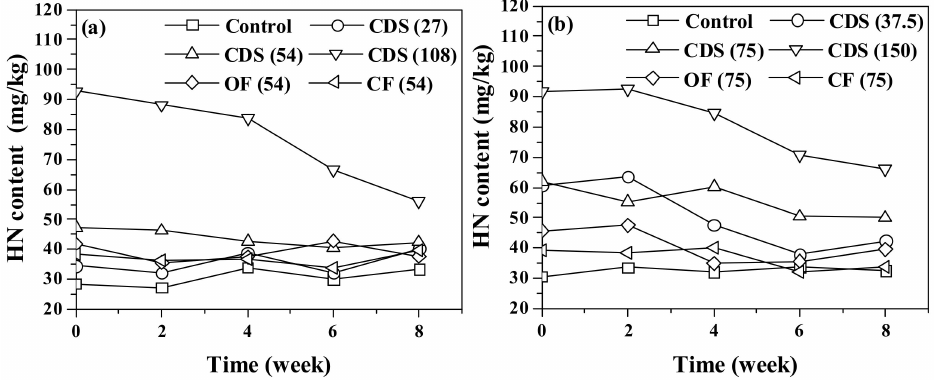
Figure 3. HN in soil affected by application of co-digestion sludge (( a ): phase one, ( b ): phase